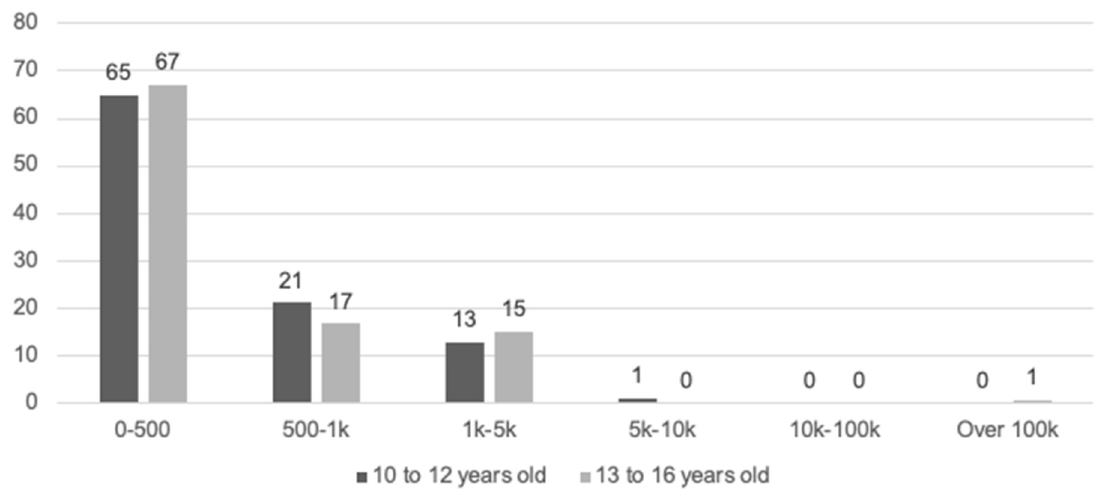
Figure 3. Number of profiles that users follow on TikTok (in percentage).